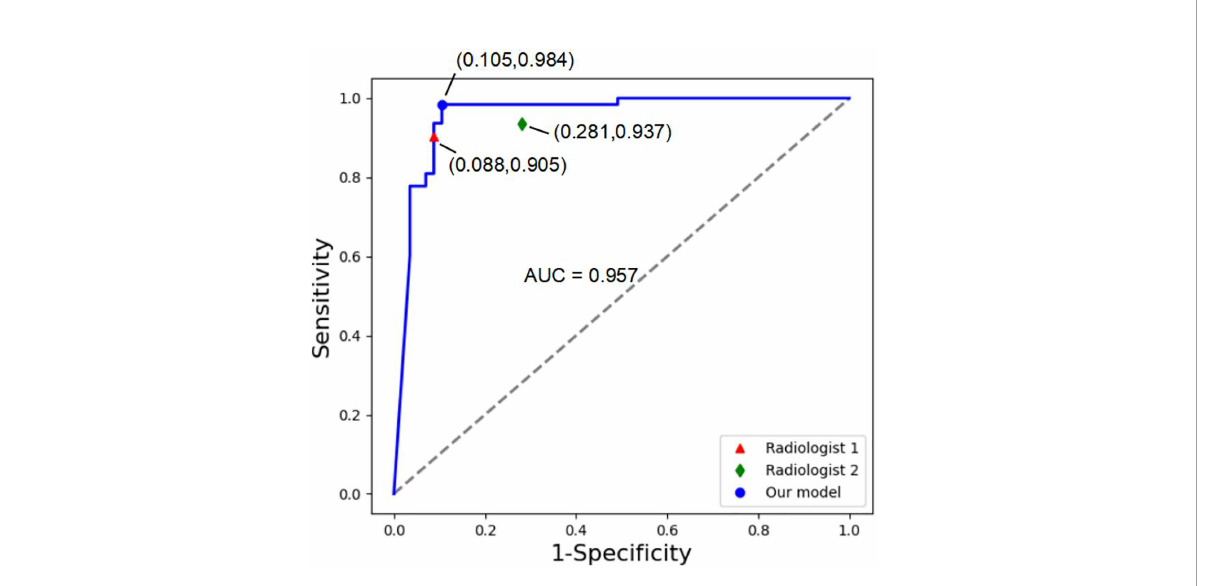
FIGURE 7 ROC curves of our MExPale model and two radiologists. Radiologist 1 comes from the First Af fi liated Hospital of Zhejiang University, and Radiologist 2 comes from a community primary hospital.